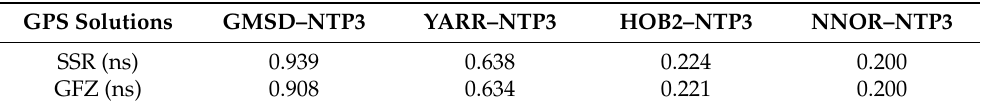
Table 4. RMS of GPS results for the time links (ns).